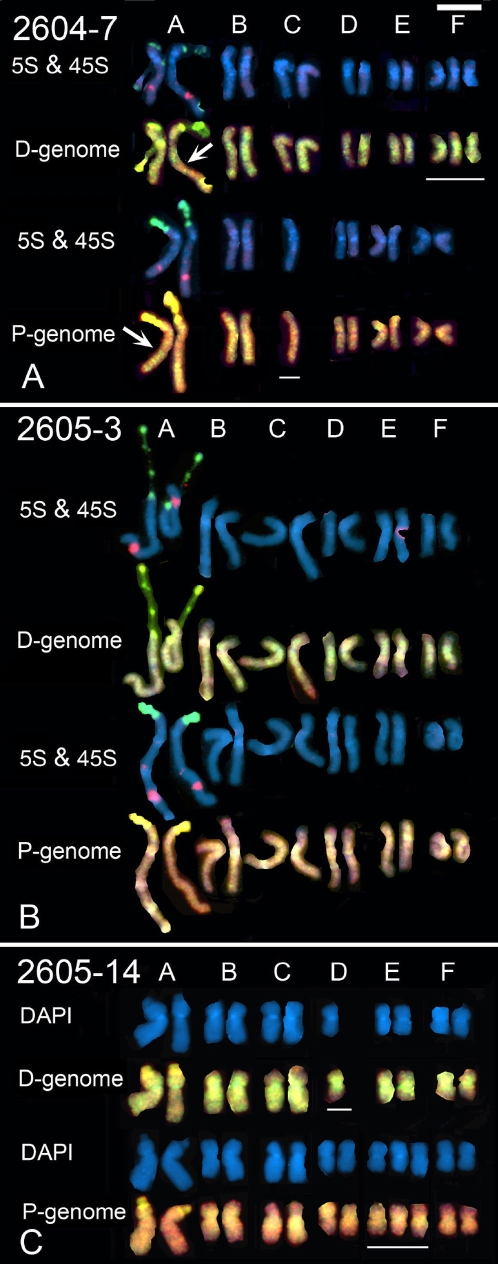
(A–C) Karyotype analyses of T. miscellus from two populations (A) 2604 and (B) 2605.Homeologous chromosome group nomenclature (A–F) follows Ownbey and McCollum [25] and Pires et al. [24]. Fluorochrome colours and probes are as in Figure 2 except that biotinylated T. pratensis genomic DNA was used in GISH experiments. Monosomic and trisomic chromosomes are underlined. Note in (A) that there is a large intergenomic translocation, chromosome Adu/pr (arrow). Scale bar (top right) is 10 µm.